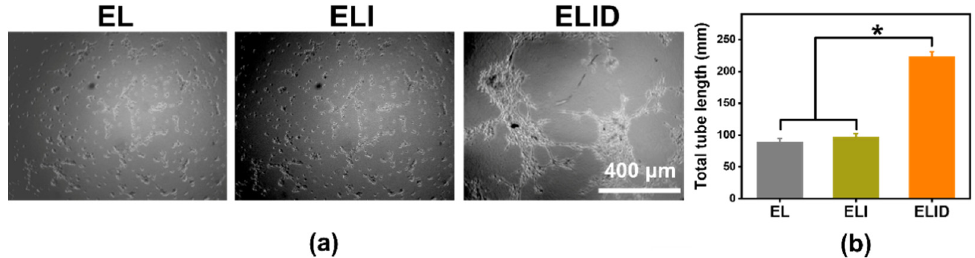
Figure 7. (a) The tube formation assay of EL, ELI, and ELID (the scale bar = 400 μ m); ( b ) the total